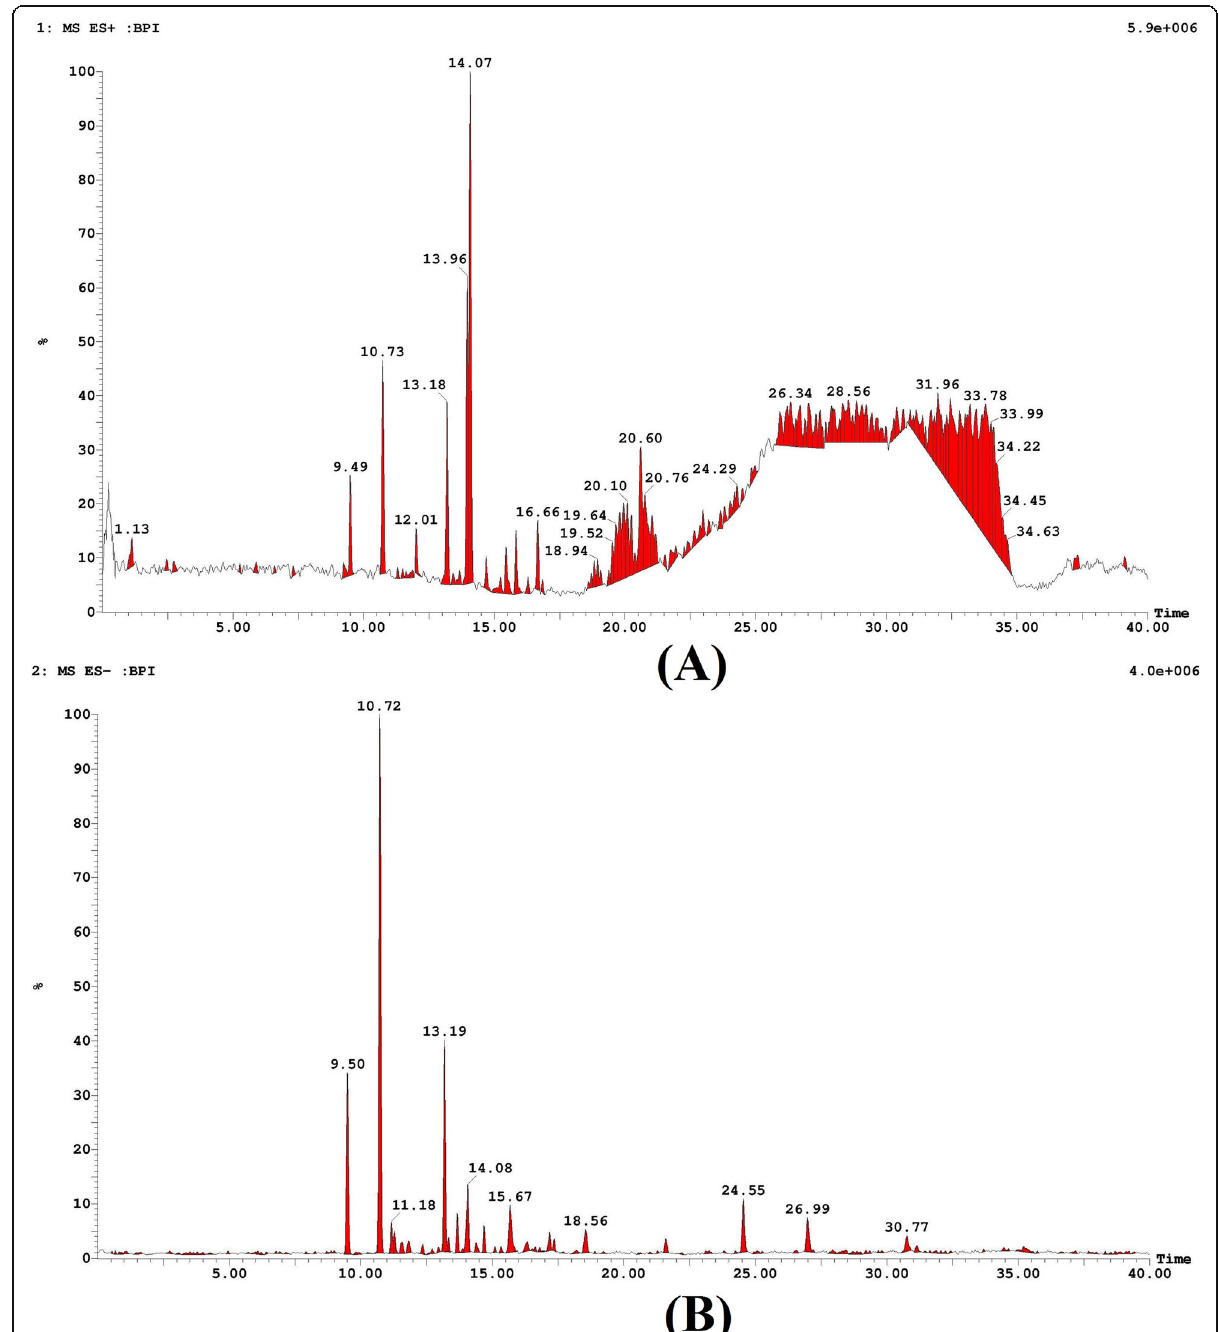
Fig. 5 Basic peak chromatogram of chloroform extract of Andrographis paniculata whole plant. a Positive ion mode. b Negative ion